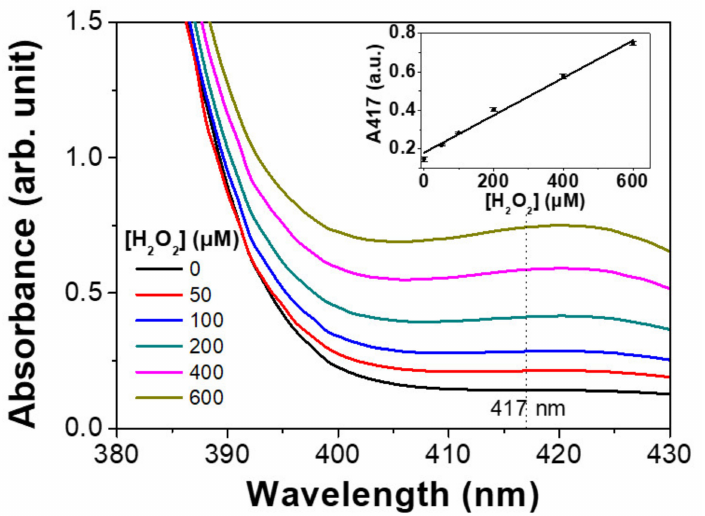
Figure 3. Colorimetric detection of H 2 O 2 using magnetic hydrogels. Absorption spectra of